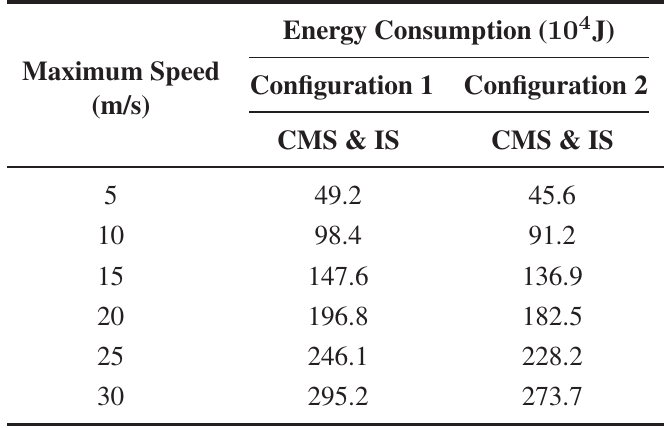
Table 2. Movement energy